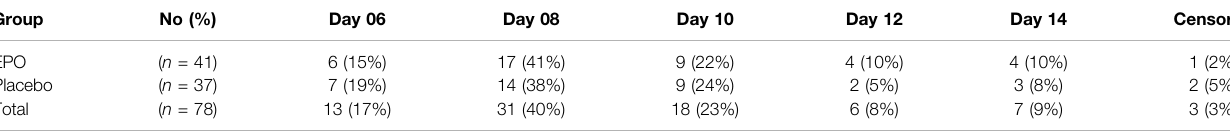
TABLE 3 | Number of patients achieving over 50% re-epithelialization. Group